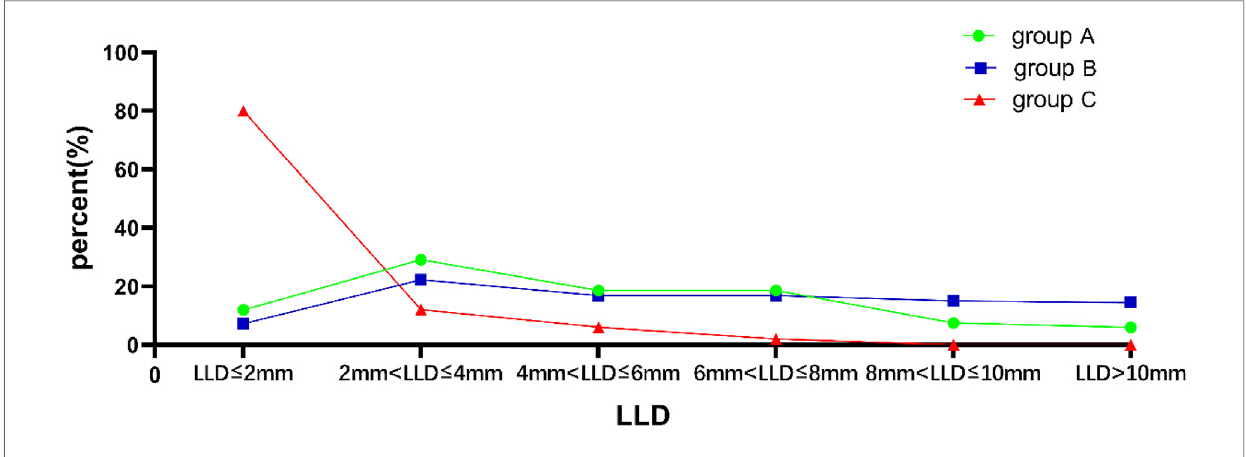
FIGURE 5 Comparison of the distribution of postoperative LLD in patients of groups A, B, and C ( p <0.001). LLD, leg length discrepancy.